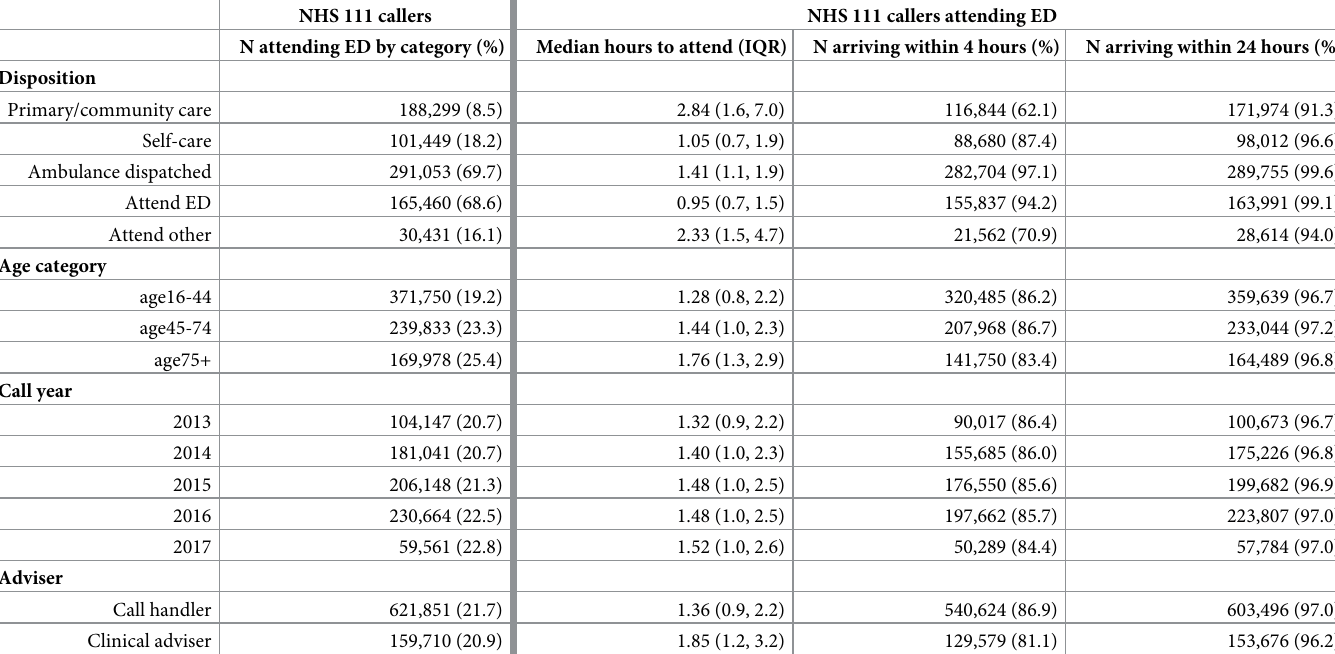
Table 1. ED attendance details for NHS 111 callers broken down by various